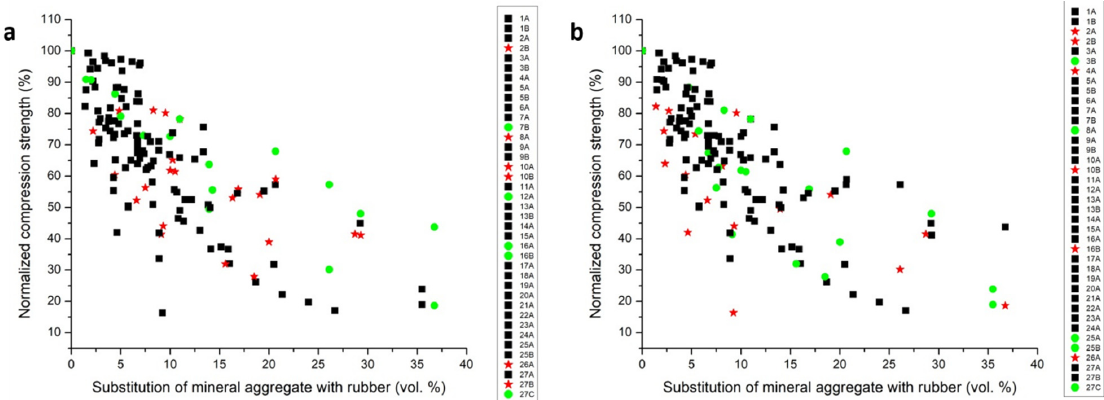
Figure 4. Reference diagram: normalized compression strength (expressed in %) vs. the volumetric percentage of substitution of the mineral aggregate with rubber (expressed in vol.%) recalculated using the fixed values of reference specific weight. ( a ) E ff ect of replacing fine aggregate (black squares), replacing coarse aggregate (red stars), replacing both fine and coarse aggregate (green circles). ( b ) E ff ect of using for aggregate replacement fine rubber (black squares), coarse rubber (red stars), fine and coarse rubber (green